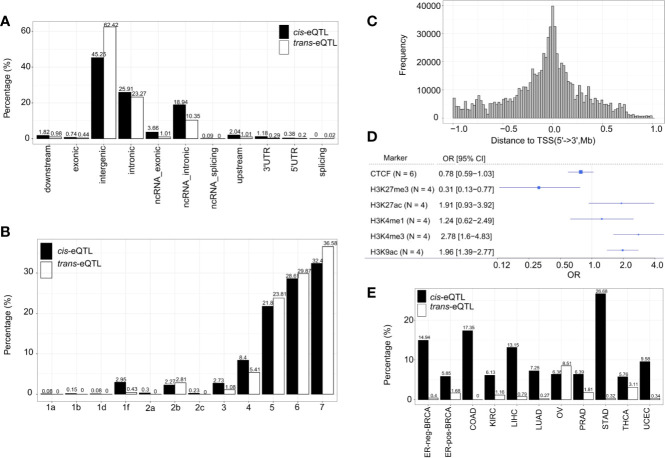
Characterization of cis/trans-eQTLs of lncRNA. (A) Genomic locations of cis/trans-eQTLs (r2≥ 0.2). (B) Distribution of RegulomeDB categories of cis/trans-eQTLs (r2≥ 0.2). (C) The location distribution of significant cis-eQTLs relative to their elncRNAs aggregated across all cancer types. (D) Meta-analysis of corresponding cancer cell lines showed significant enrichment of cis-eQTLs in H3K27Me3, H3K4Me3, and H3K9Ac. (E) The percentage of cis/trans-eQTLs that are associated with GWAS risk loci in 11 TCGA cancer types.